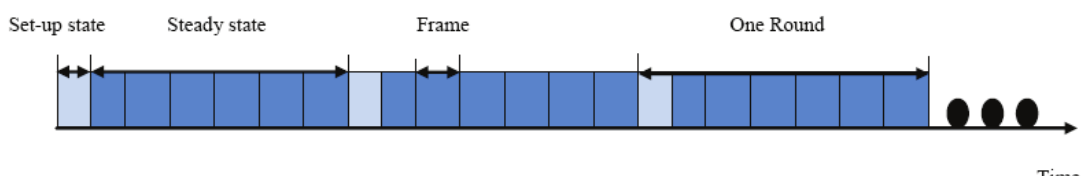
Figure 2. Working Cycle of the LEACH